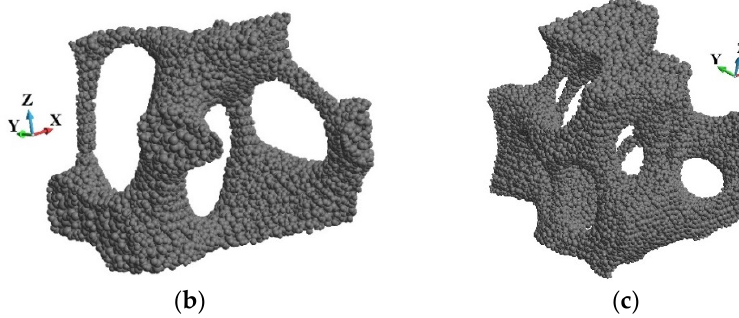
Figure 18. Regions of the sample chosen for detailed analysis, region o1 in yellow, region o2 in pink, and region o3 in brown.